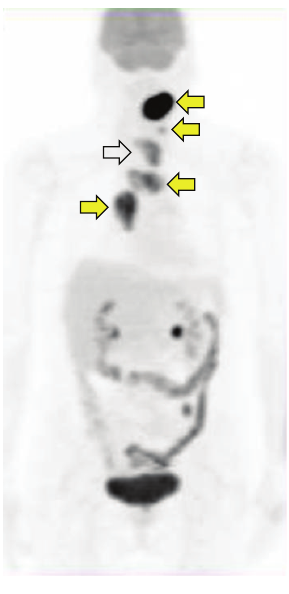
Figure3:FDG-PETina48-year-oldfemalewithPDTCshowingthe presence of increased uptake in the thyroid tumour (white arrow) and multiple cervical and mediastinal lymph nodal metastases (yellow